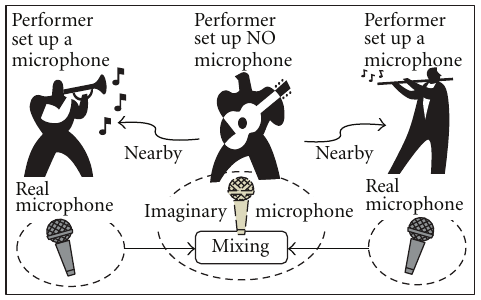
Figure 2: Creation of imaginary